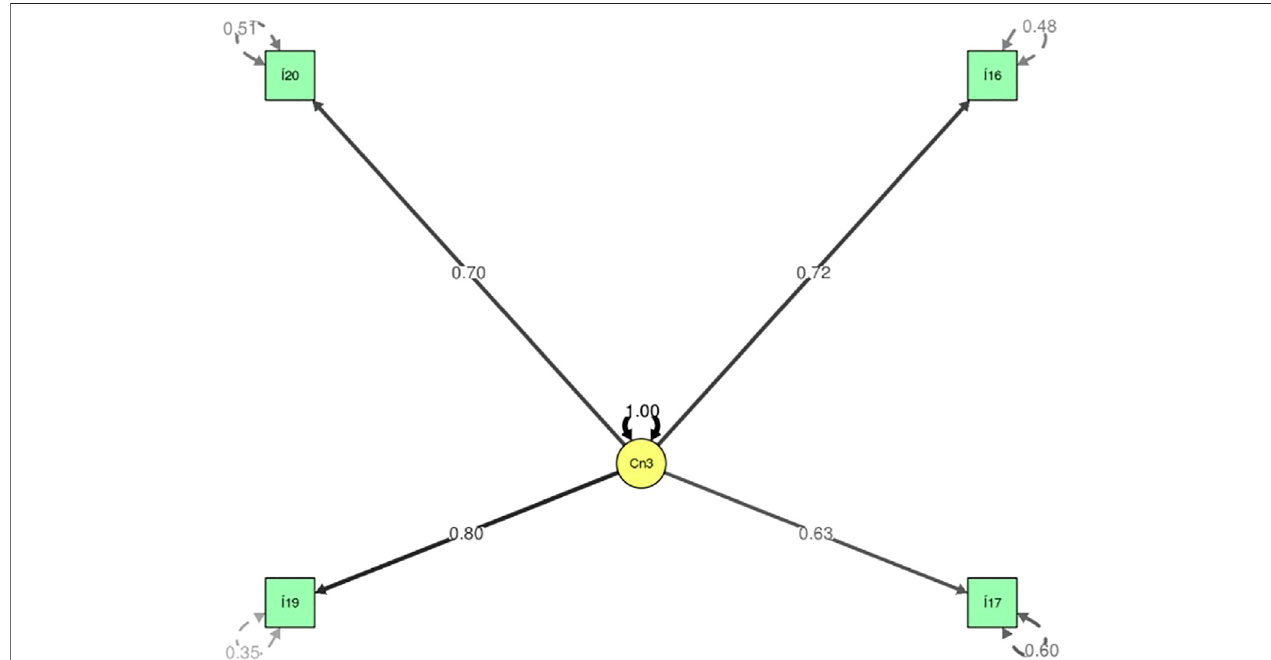
FIGURE 3 | Structural equation model. Factor